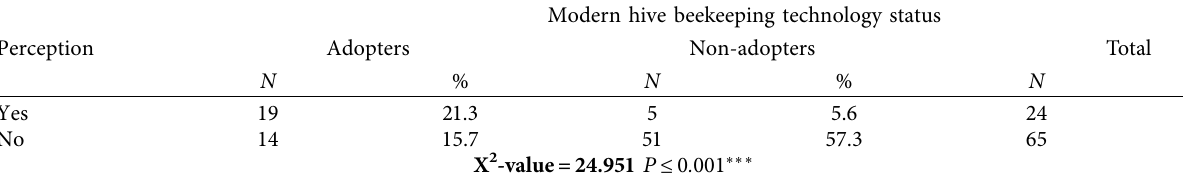
Table 15: Distribution of perception of respondents.